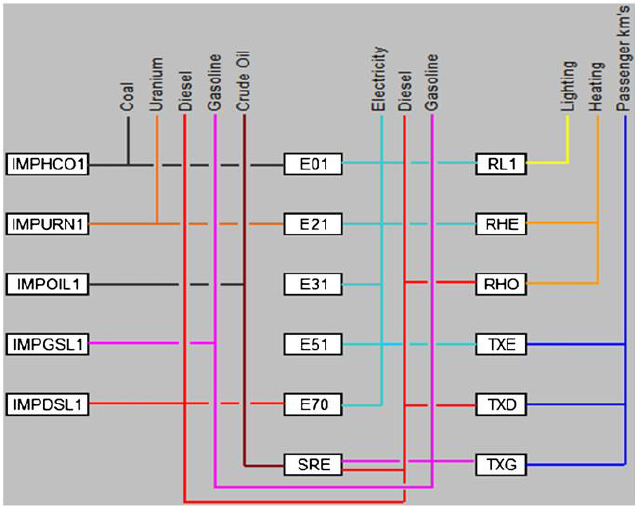
Figure 3. Reference energy system (RES) of UTOPIA (taken from Reference [10]).